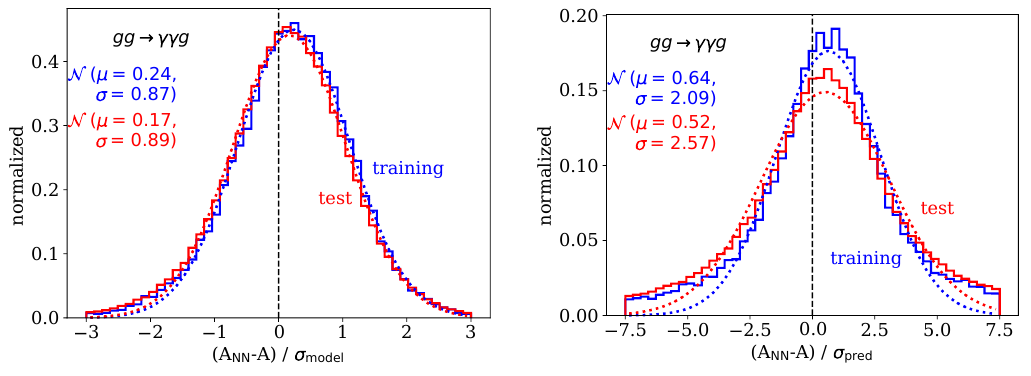
Figure 3: Pulls for the BNN, defined in Eq.(17) and evaluated on the training and test